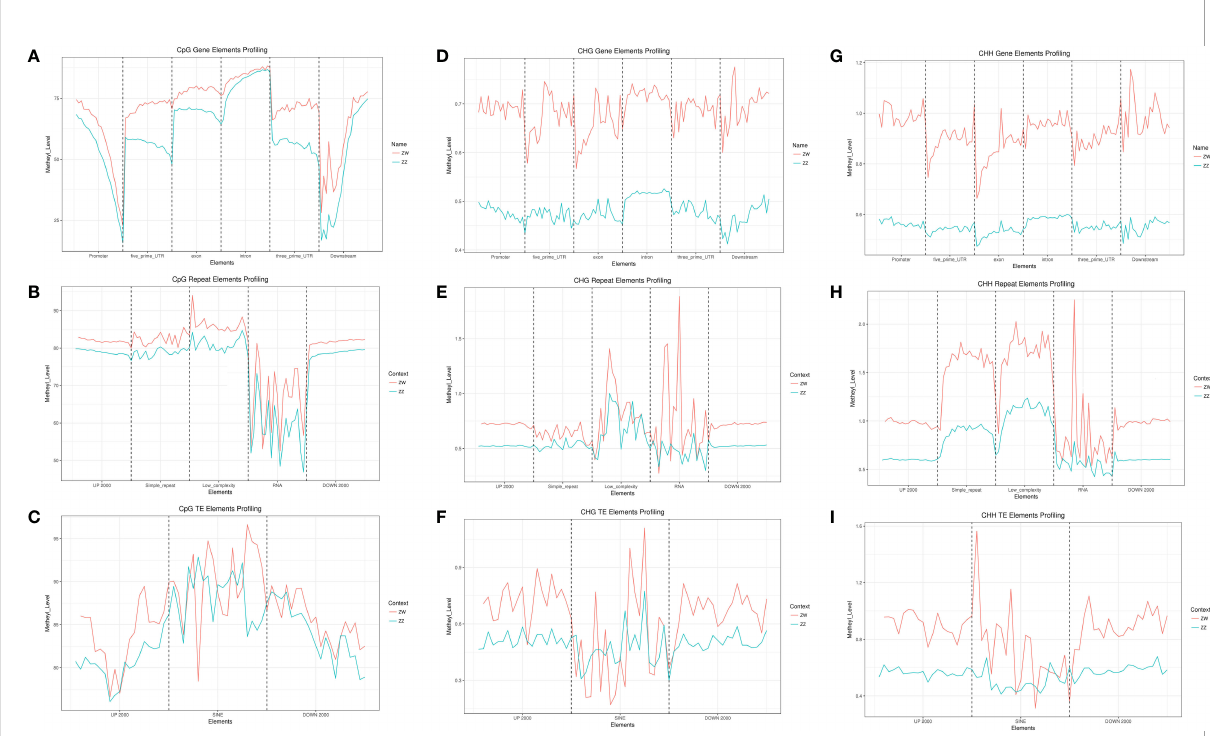
FIGURE 3 Genomic elements of three contexts of mC sites (CG, CHG, CHH) methylation pro fi ling in ZW and ZZ groups. (A) CpG gene elements pro fi ling of both ZW and ZZ groups. (B) CpG repeat elements pro fi ling of both ZW and ZZ groups. (C) CpG TE elements pro fi ling of both ZW and ZZ groups. (D) CHG gene elements pro fi ling of both ZW and ZZ groups. (E) CHG repeat elements pro fi ling of both ZW and ZZ groups. (F) CHG TE elements pro fi ling of both ZW and ZZ groups. (G) CHH TE elements pro fi ling of both ZW and ZZ groups. (H) CHH TE elements pro fi ling of both ZW and ZZ groups. (I) CHH TE elements pro fi ling of both ZW and ZZ groups. The red line represents ZW group and the blue line represents ZZ